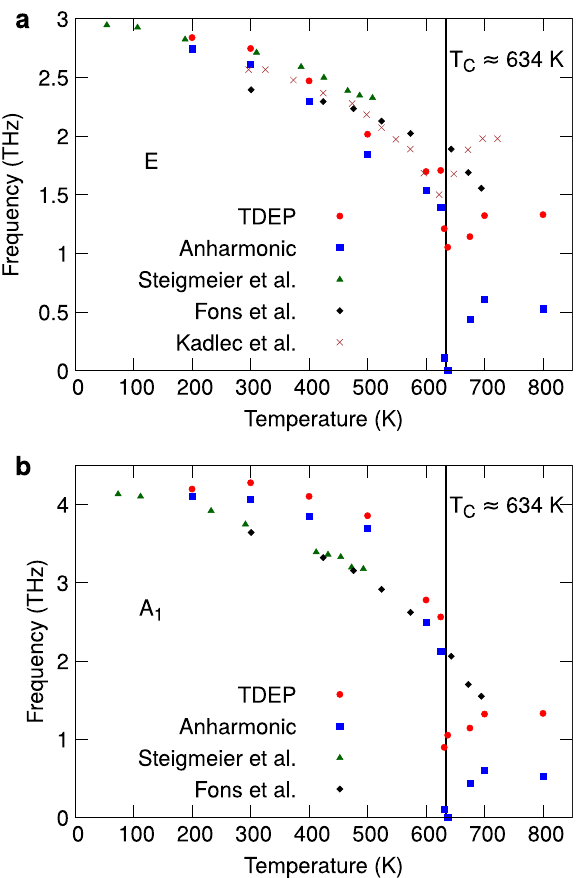
Fig. 1 Temperature dependence of the zone centre optical phonon frequencies. a The lower transverse optical (TO) mode ( E ) and b the higher TO mode ( A 1 ) at the zone centre as we approach q = 0 along the X − Γ direction, perpendicular to the trigonal axis. Red circles and blue squares represent the calculated temperature- dependent effective potential (TDEP) and anharmonic phonon frequencies, while other symbols represent the experimental results from refs. 43,45,48 . The TDEP frequency is the square root of the eigenvalue of the dynamical matrix at a particular temperature, while the anharmonic frequency is the peak of the phonon mode power spectrum. The black vertical line represents the phase boundary between the rhombohedral and rocksalt structures in our calculations ( ≈ 634